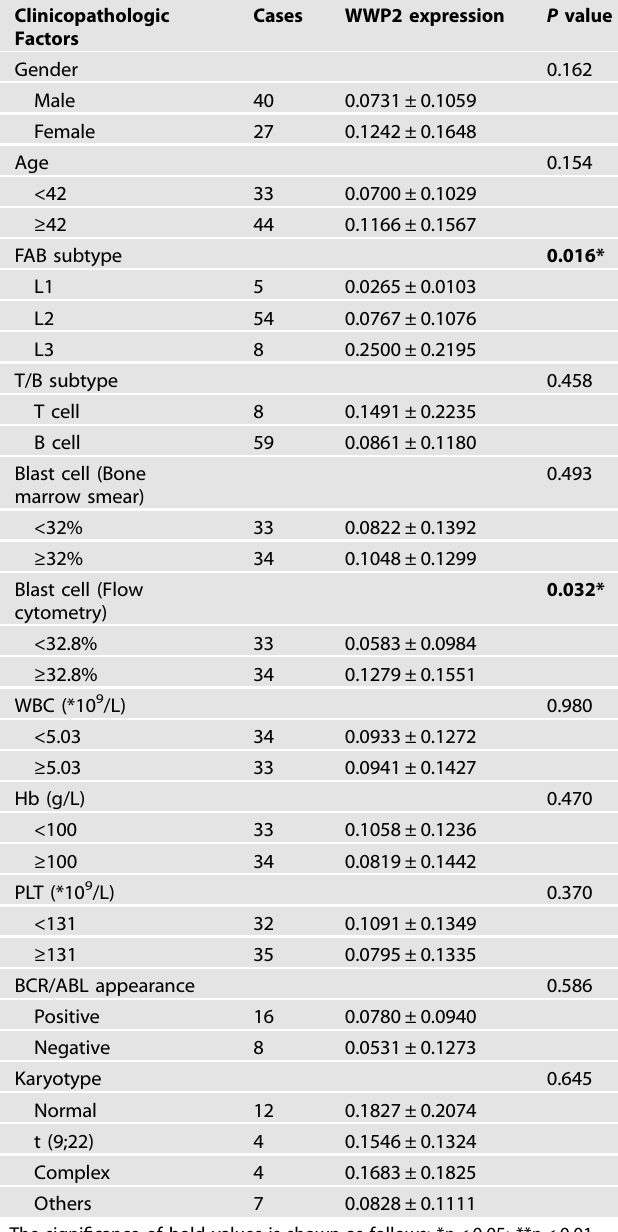
Table 1. Correlation between WWP2 expression and clinicopathologic factors in ALL